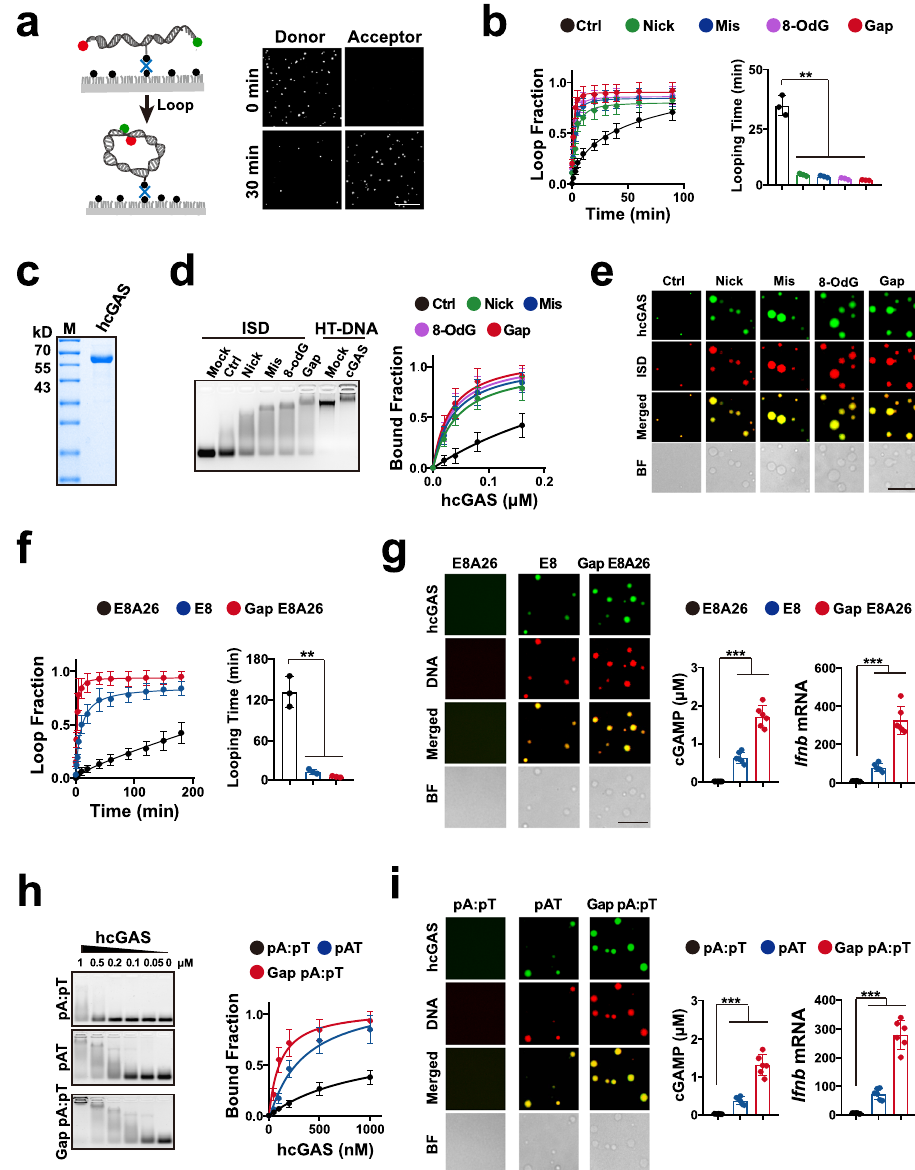
Fig.2|DNA- fl exibilitycontrolsDNA-potentialtobindandactivatecGAS.a DNA looping assay schematic and fl uorescence images of single DNA in donor and acceptor channels after 1M NaCl treatment for noted time. Scale bar=10 μ m. b LoopfractionandtimeofdamagedISDs.Inthisstudy,dataarepresentedasmean values±standard deviations (SDs), and error bars indicate SDs (Mean±SD). n =3 independent experiments. c Coomassie staining of puri fi ed human cGAS (hcGAS) protein. M: Marker; kD: kilodaltons. d Left: EMSA of hcGAS binding to noted ISD using HT-DNA as control. Right: EMSA bound fraction of 50nM ISDs binding to serial dilutions of hcGAS protein. Mean±SD. n =3 independent experiments. e RepresentativeimagesofhcGAS – DNAcondensatesaftermixing2 μ MhcGASwith 2 μ MISD.Red:Cy3-labelledDNA;Green:AlexaFluor-488(AF-488)-labelled hcGAS; BF: bright fi eld. Scale bar=20 μ m. f Looping fraction and times of noted ISDs. Mean±SD. n =3 independent experiments. g Left: Representative images of